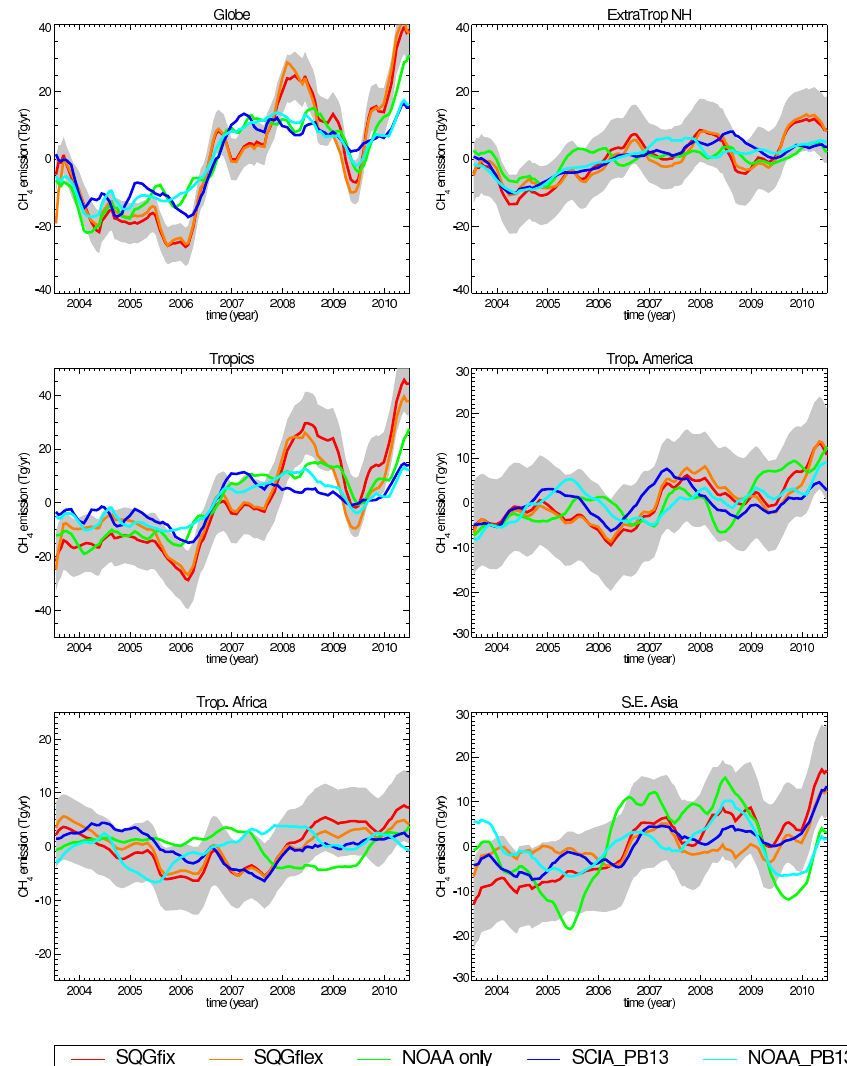
Fig. 13. As Fig. 12, with comparison to the results from the NOAA-only (S1-NOAA) and NOAA+SCIA (S1-SCIA) inversion from Bergamaschi et al. (2013).